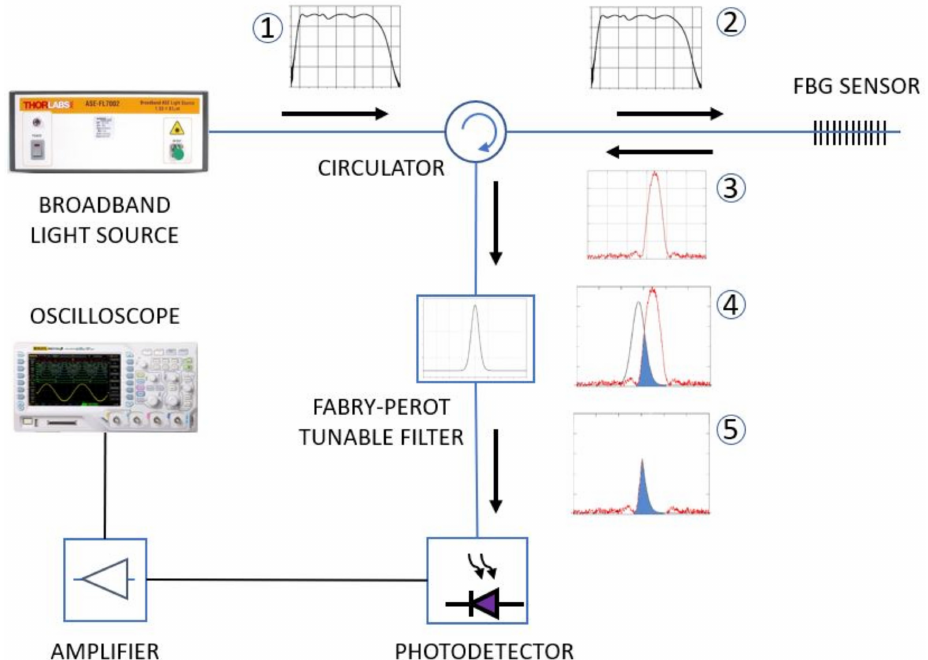
Figure 4. The FBG interrogation setup based on a Fabry-Perot tuned filter. Numbered squares show the spectra of the signal as it travels through the different components until reaching the photodetector, where it is converted into a voltage proportional to the FBG peak displacement and read by the